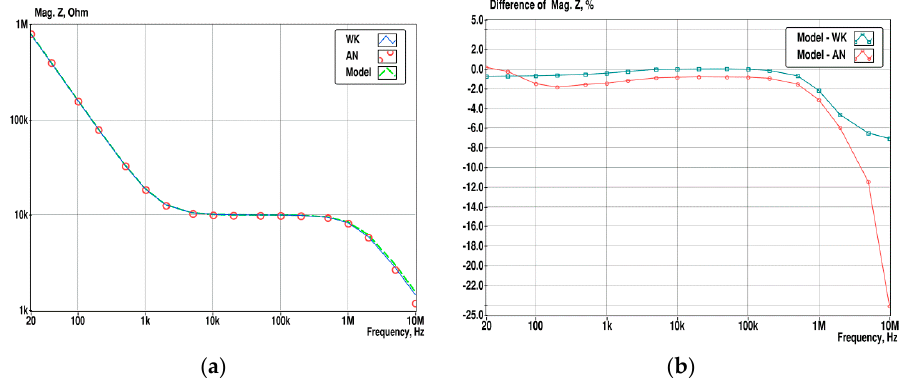
Figure A8. Impedance magnitudes ( a ) of the SUT2 measured with the Wayne Kerr analyzer (WK), the developed analyzer (AN), and calculated from the computer model with the nominal values of its components; ( b ) relative deviations of the model’s impedance magnitude from the values measured with WK and AN.